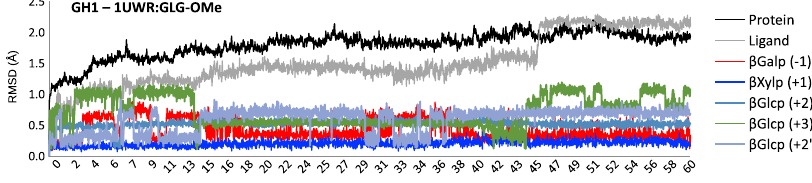
Figure 8. Relative flexibility at different subsites of bound residues from a xyloglucan-derived pentasaccharide against S. solfataricus β -glycosidase LacS during a MD simulation. The relative flexibility of the different carbohydrate residues depicted in Fig. 7b are shown for the residues at positions − 1 (red), + 1 (dark blue), + 2 (steelblue), + 3 (green) and + 2’ (light slategray) and contrasted with those of the full ligand (silver) and of the full protein (black) throughout 3,000 time steps of a 60 ns MD